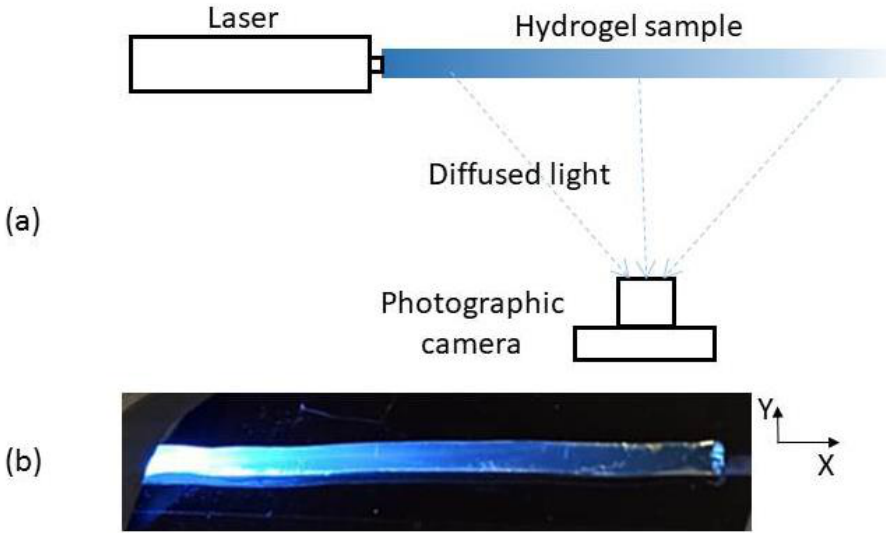
Figure 1. ( a ) Scheme of the experimental setup. Sizes and distances are not drawn to scale. ( b ) Picture of a hydrogel sample fed at its left end with the laser centered at 450 nm. The coordinate system to be employed later is specified.